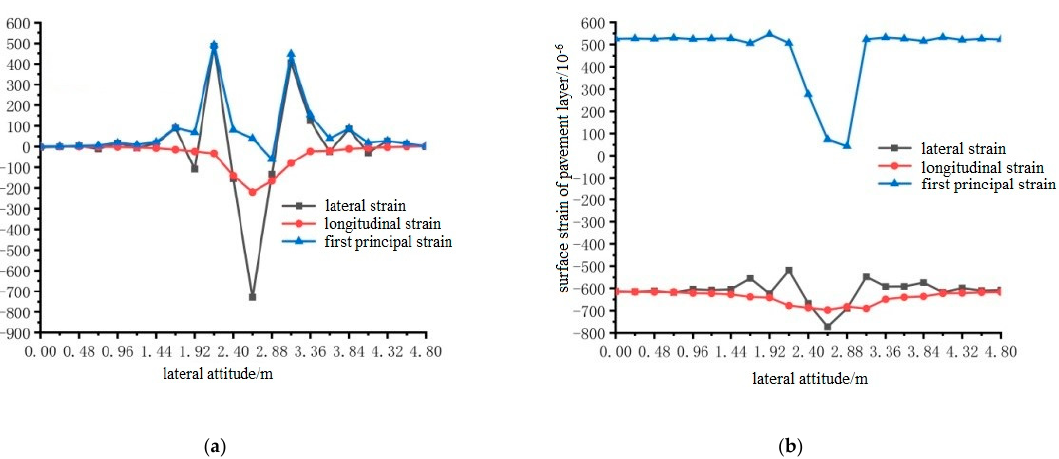
Figure 29. The transverse distribution of longitudinal and transverse strain on the surface of the pavement with and without temperature field under the action of load level 3. ( a ) Longitudinal and transverse strain diagrams without temperature field effect; ( b ) Longitudinal and transverse strain diagrams with temperature field effect.